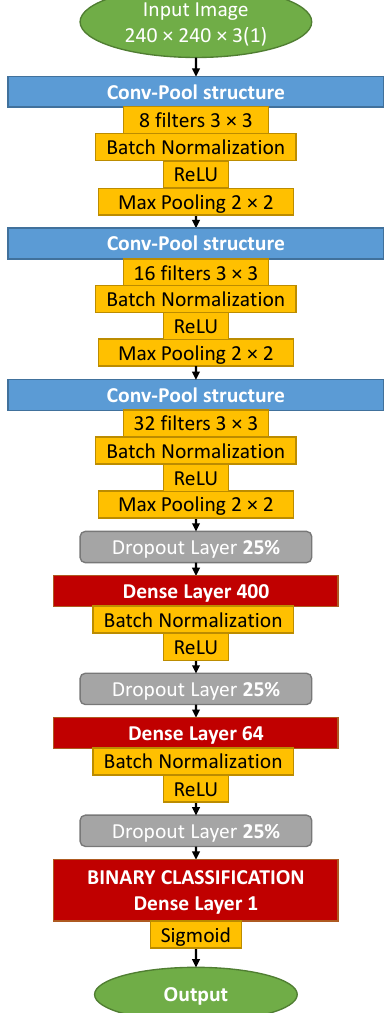
Figure 3. OilNet40 CNN diagram